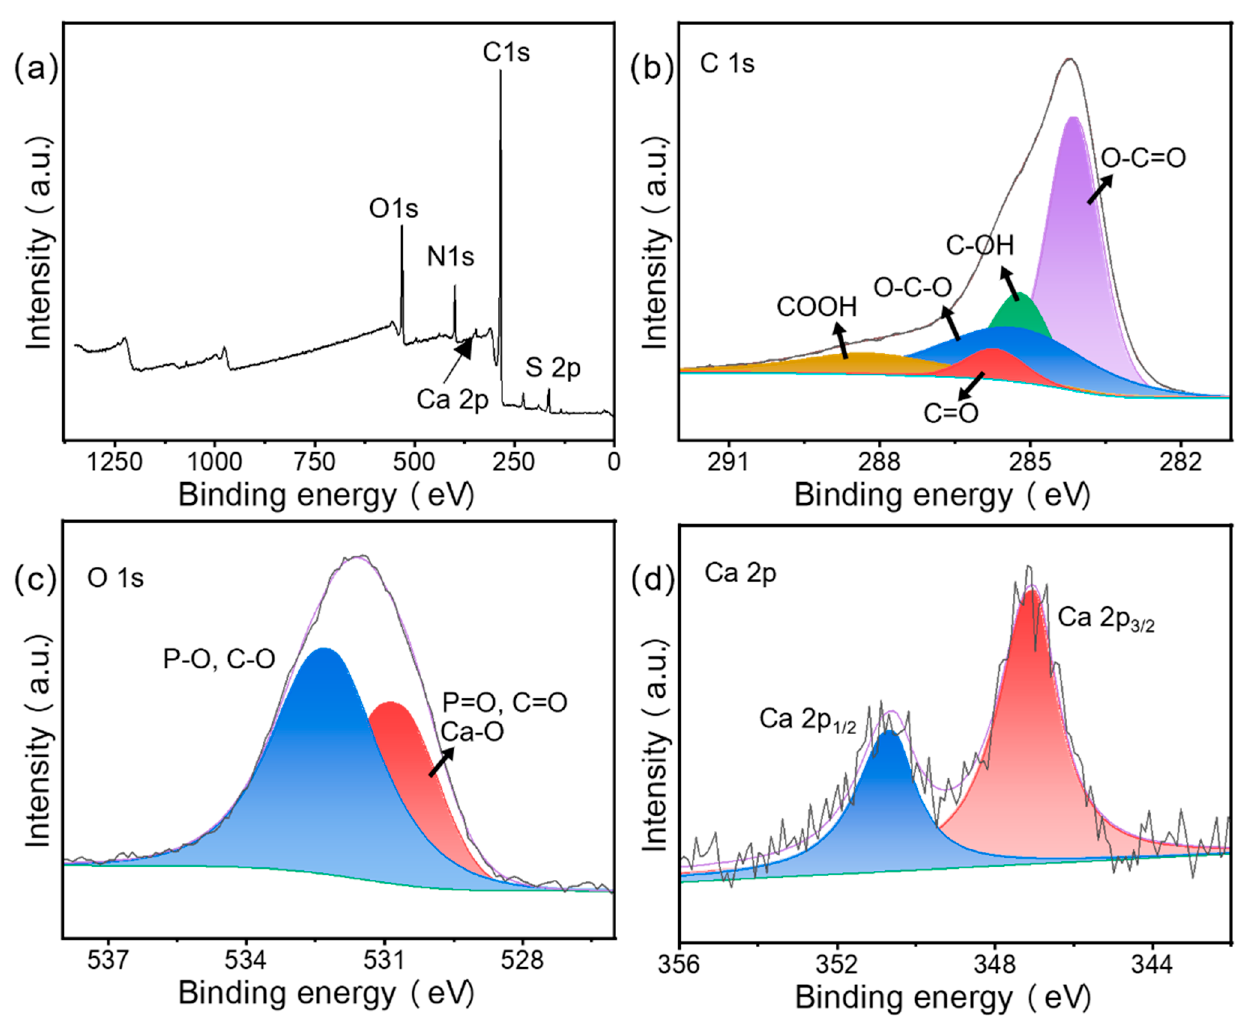
Figure 10. XPS full spectra of ( a ) MCS3-1 after adsorption and photocatalysis, ( b ) C 1s, ( c ) O 1s, and ( d ) Ca 2p.